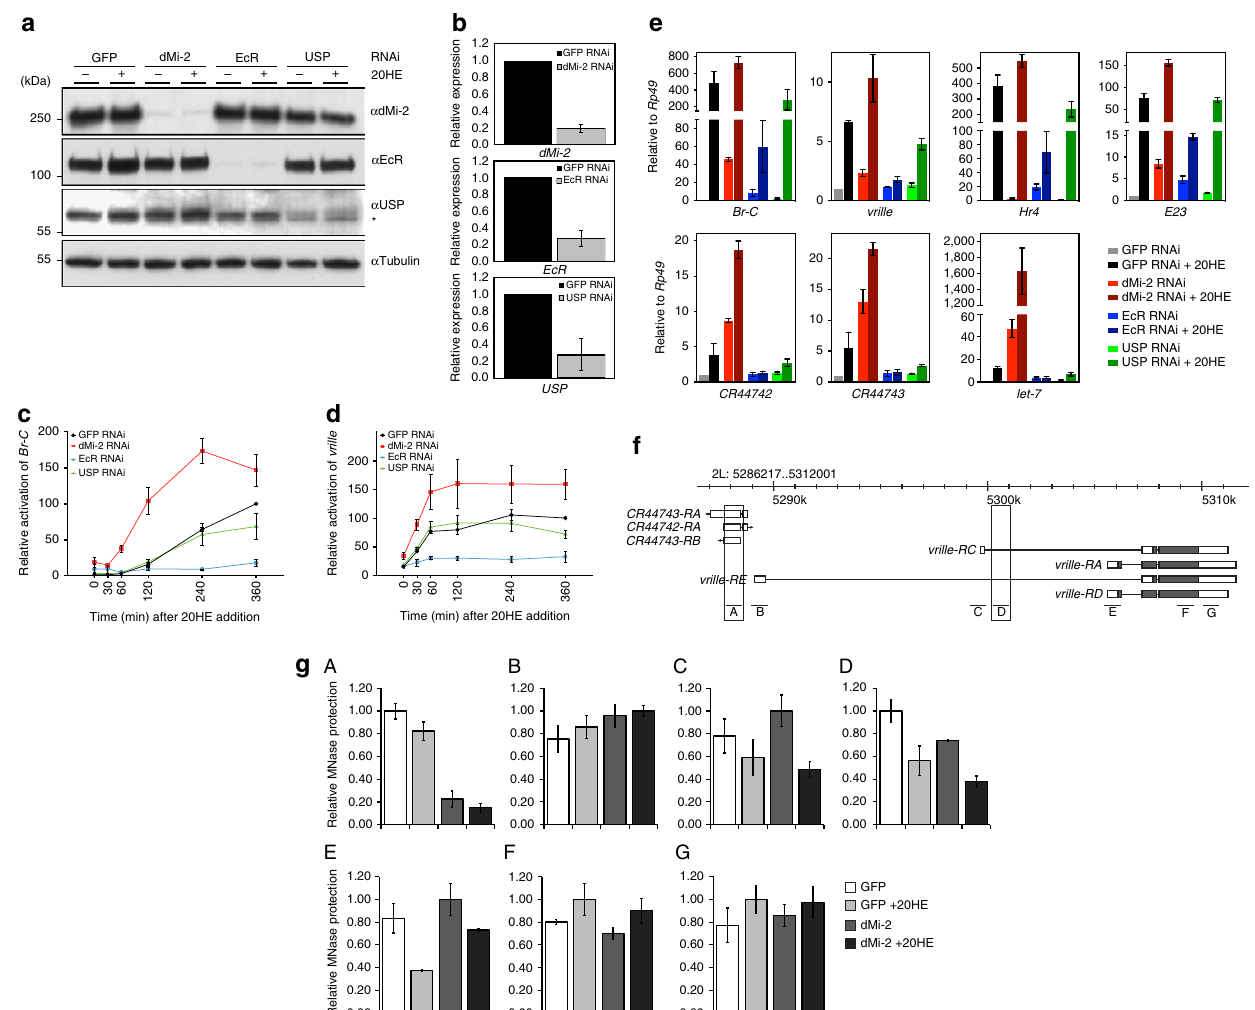
Figure 2 | dMi-2 constrains the transcription of ecdysone-activated genes and contributes to a closed chromatin structure. ( a ) S2 cells were RNAi-depleted of GFP (control), dMi-2, EcR or USP and either left untreated ( (cid:2) 20HE) or were treated with 1 m M ecdysone for 6h ( þ 20HE). Nuclear extracts were prepared and analysed by western blot. Asterisk (*) denotes USP antibody-crossreactive protein. Tubulin served as loading control. Representative examples of three independent RNAi experiments are shown. ( b ) RT–qPCR analysis of dMi-2 (top), EcR (middle) and USP (bottom) expression. RNA levels in control cells (GFP RNAi) were set to 1 and RNA levels in other RNAi-treated cells are depicted relative to the level in control cells. ( c ) Time course of Br-C and ( d ) vrille RNA expression over 6h of ecdysone treatment. Before ecdysone addition, cells were RNAi-depleted of GFP (control), dMi-2, EcR or USP as indicated. RNA levels were determined by RT–qPCR relative to rp49 and adjusted to 100 at the latest time point of control cells (GFP RNAi). Other ratios were expressed relative to this. Data shown are mean value ± s.e.m. of three independent experiments. ( e ) Derepression of ecdysone-regulated genes after dMi-2, EcR and USP depletion. S2 cells were RNAi-depleted of GFP (control), dMi-2, EcR or USP. Cells were then left untreated or were treated for 6h with 1 m M 20HE as shown. Data shown are mean value ± s.e.m. of two independent experiments. ( f ) Schematic representation of amplimer positions (A – G) within the vrille locus. Note that regions A and D contain EIMRs (see Fig. 1e). ( g ) Cells were RNAi-depleted of GFP (control) or dMi-2 and then left untreated or treated with ecdysone ( þ 20HE). Chromatin was prepared, digested with MNase and amplified by qPCR. Relative MNase protection was calculated and plotted (see Methods section). The sample with the highest MNase protection value for each genomic region was set to 1. Error bars denote s.d. of technical triplicates. Experiment was performed as biological triplicates, one representative experiment is